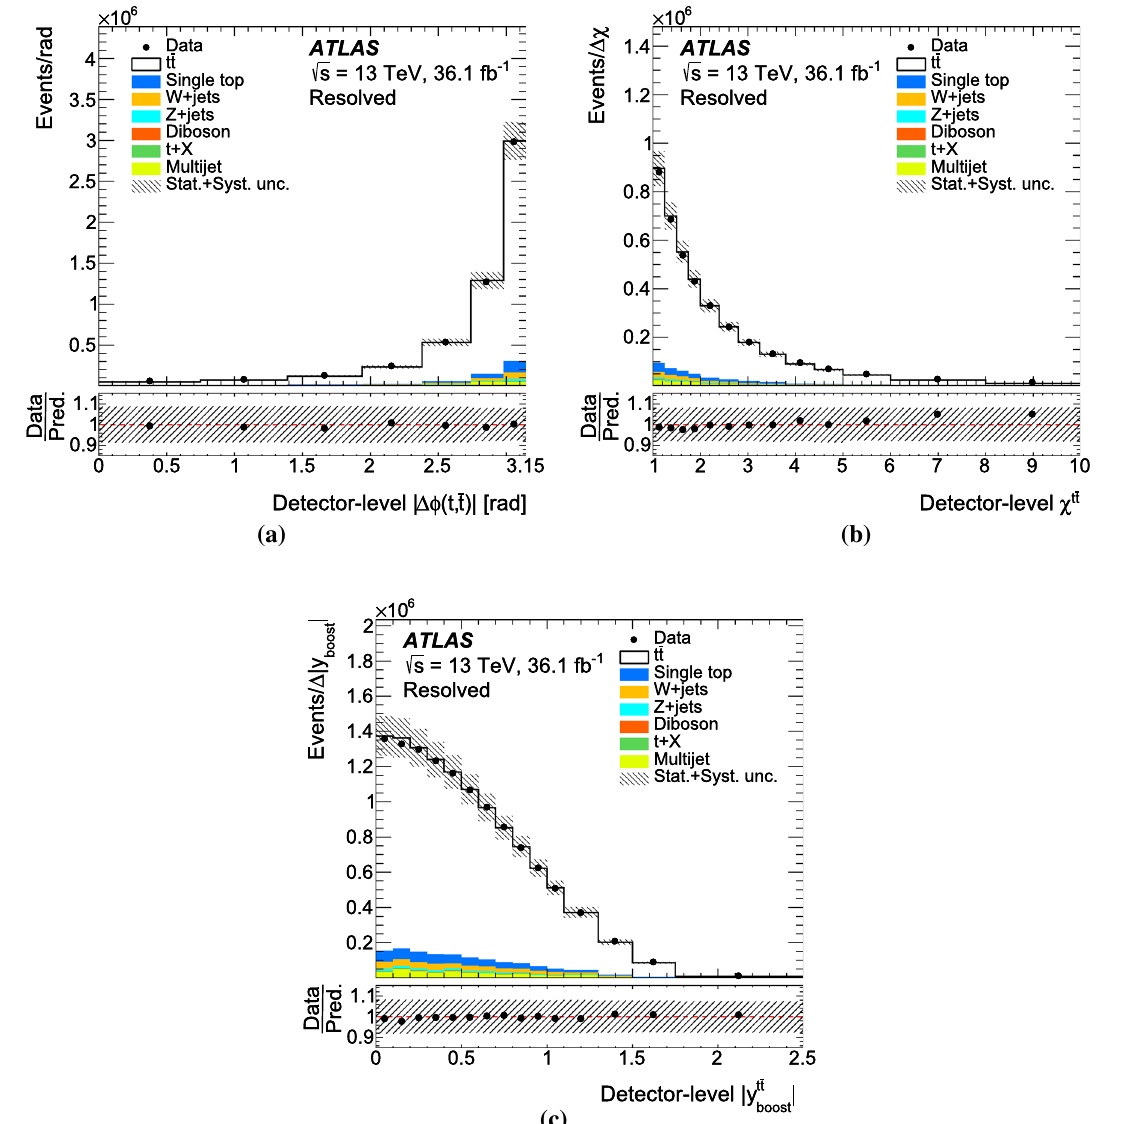
Fig. 10 Distributions of observables in the (cid:3) + jets channel recon- structed with the pseudo-top algorithm in the resolved topology at detector-level: a azimuthal angle between the two top quarks (cid:7) (cid:5)(cid:7) (cid:4) (cid:7) (cid:8)φ (cid:7) , b production angle χ t ¯ t and c absolute value of the longi- t , ¯ t . Data distributions are compared with predictions, tudinal boost y t ¯ t boost using Powheg + Pythia8 as the t ¯ t signal model.The hatched area rep-